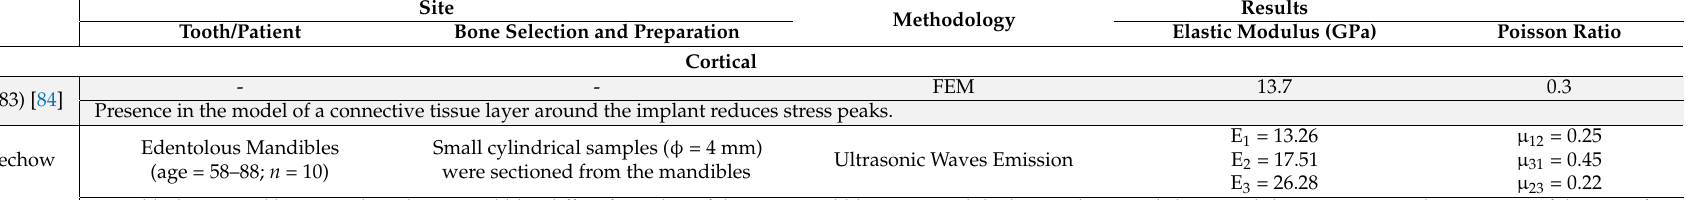
Table 5. Data for Mandible and Maxilla Mechanical